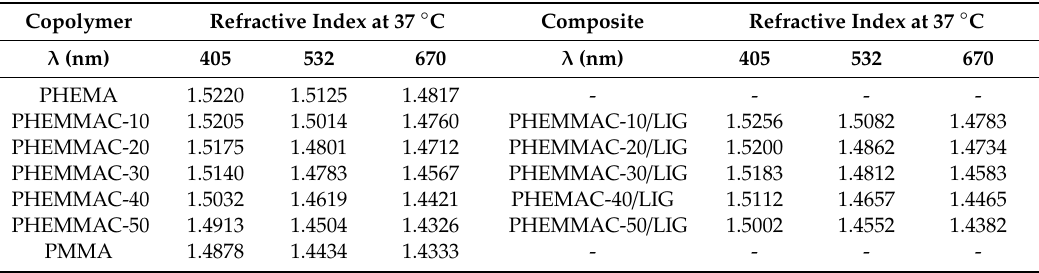
Table 7. Comparative table of the refraction indices values measured for the virgin PHEMMAC and PHEMMAC / LIG systems with di ff erent MMA contents.